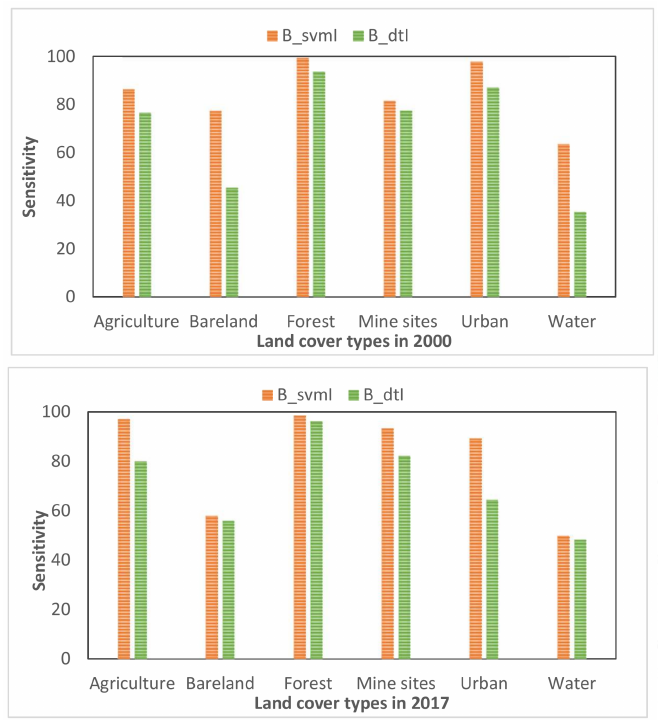
Figure 2. The sensitivity of each land cover types in 2000 and 2017 classification method I images using dataset (A) and (B) and two di ff erent machine learning algorithms against 2000_619_7_A_svmI and 2017_829_8_A_svmI.